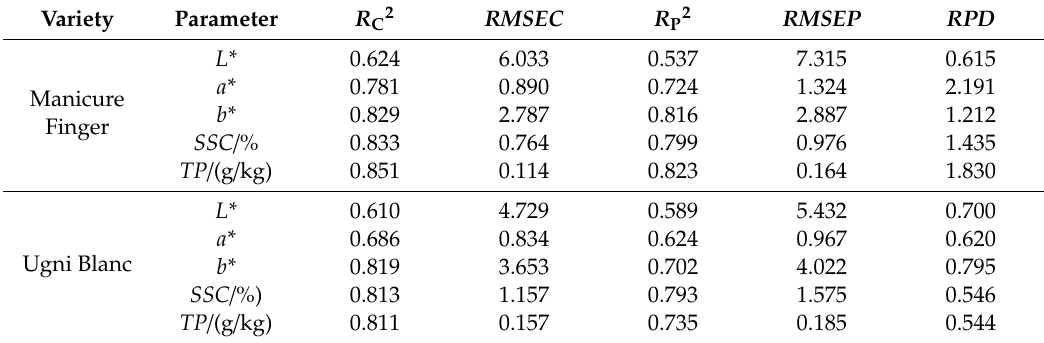
Table 3. PLS regression for SSC , color, and TP of Manicure Finger and Ungi Blanc berries based on full band spectra.